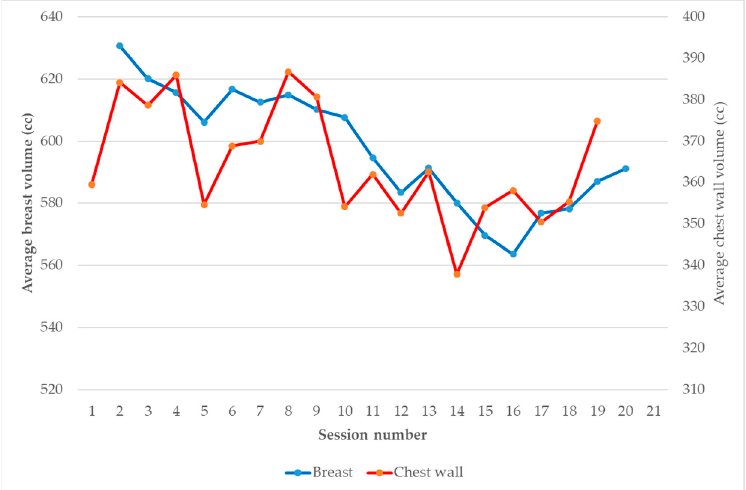
Figure 4. Evolution of the breast (blue line) and chest wall (red line) CTV volume during the ses- sions .